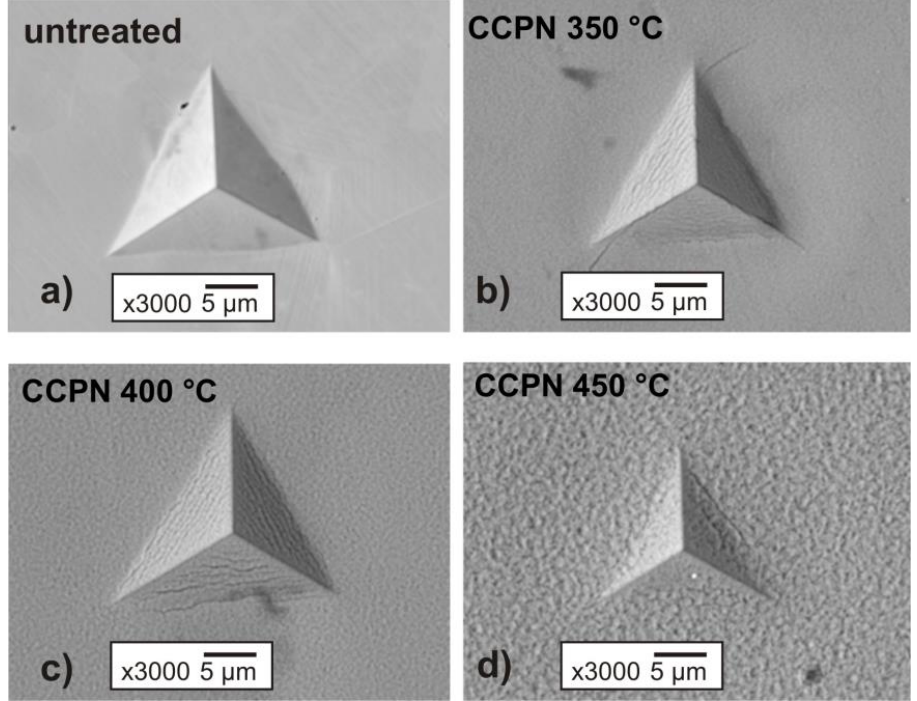
Figure 10. SEM micrographs of residual impressions produced by Berkovich tip indentation on untreated ( a ) and CCPN-nitrided ( b – d ) AISI 316 steel samples.